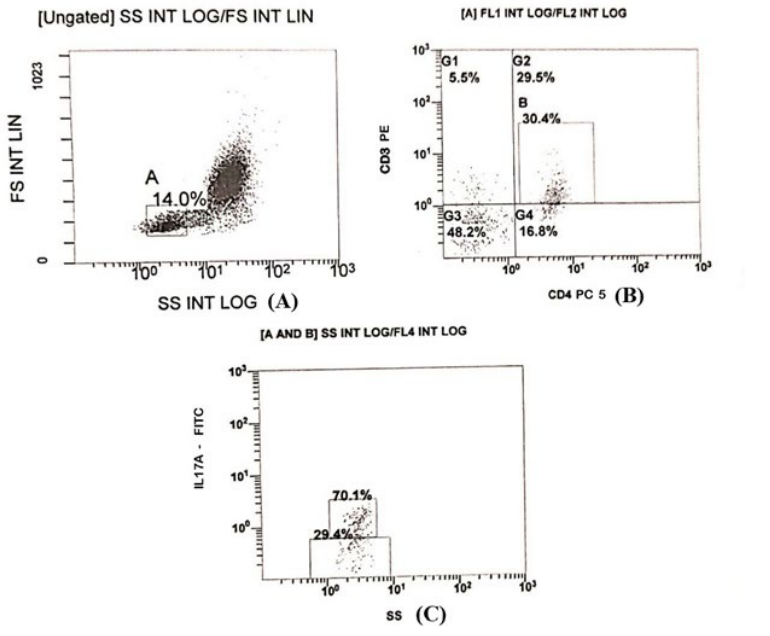
Fig.2. lymphocytes stained with anti CD3 PE, CD4 PC5 and anti IL-17A FITC 1. dot blot of forward scatter (FS) versus SS (side scatter) shows lymphocytes gate A which represent 14% of the harvested cell populations. 2. (b) A dot plot of anti CD3 PE against anti CD4 PC5 shows that 30.4 % of the gated lymphocytes populations were CD3 + CD4 + , a gate G2 included this population 3. CD3 + CD4 + lymphocytes were examined for expression of IL-17A FITC, the dot blot demonstrates that 70% of the CD3 + CD4 + lymphocytes population express high levels of IL-17A as shown in figure 2-(C) So, Th-17 percentage was 20.68 % of the total lymphocytes in this sample as Th-17 cells were identified as CD3+CD4 + IL-17A +